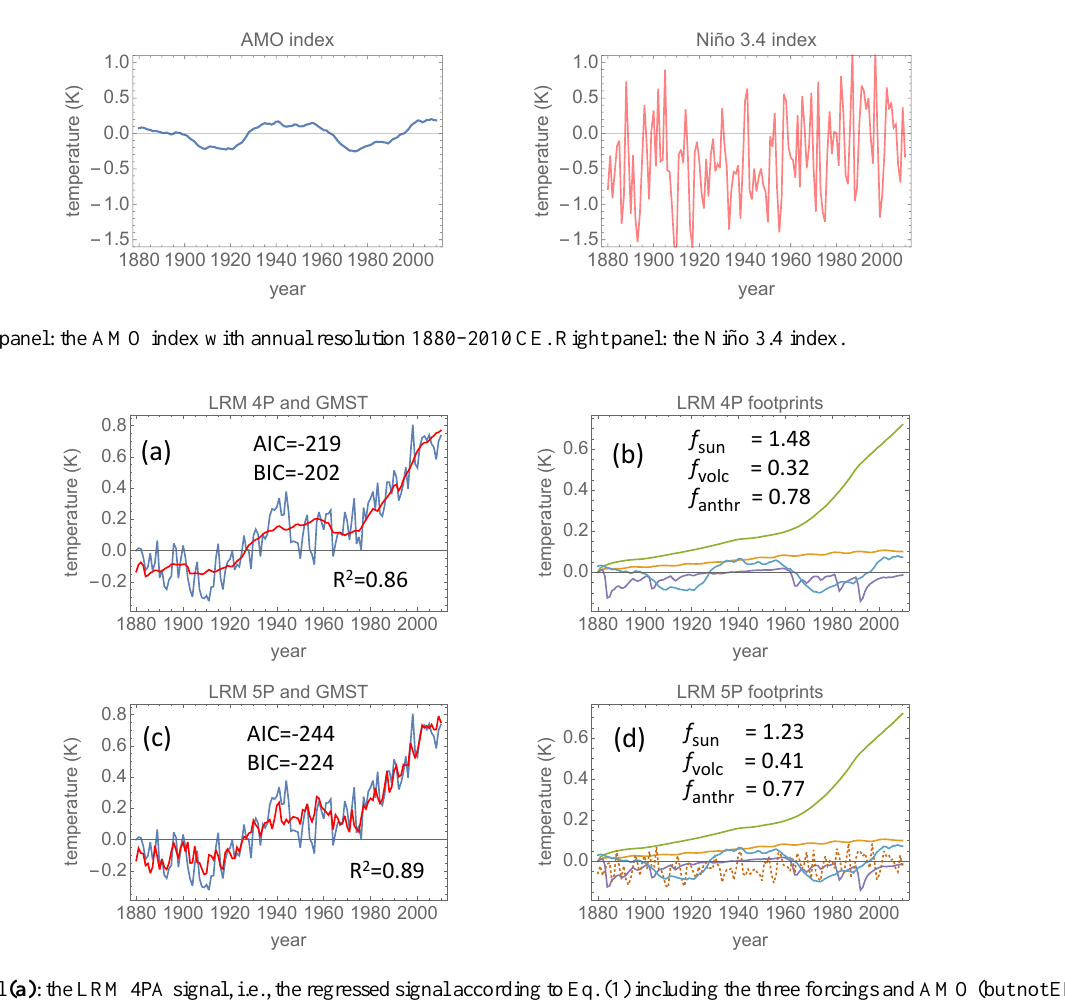
prints relative to the LRM3 model shown in Fig. 3d,